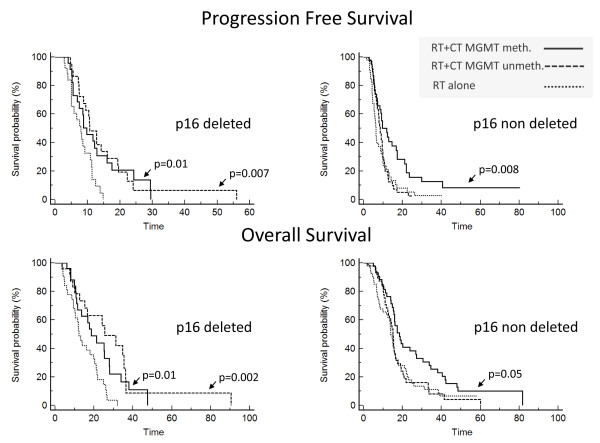
Survival according to treatment, radiotherapy alone or radiotherapy and adjuvant chemotherapy, p16 deletion and MGMTP methylation in an independent series of 222 GBMs. The y-axis corresponds to the survival probability and the x-axis to survival time (months). Survival curves on the left correspond to the patients with p16 deletions; survival curves on the right correspond to patients without p16 deletions. These survival curves show that patients with p16 deletions benefit from adjuvant chemotherapy regardless of their MGMTP methylation status, whereas patients without p16 deletions benefit from adjuvant chemotherapy only when they have a methylated MGMTP.